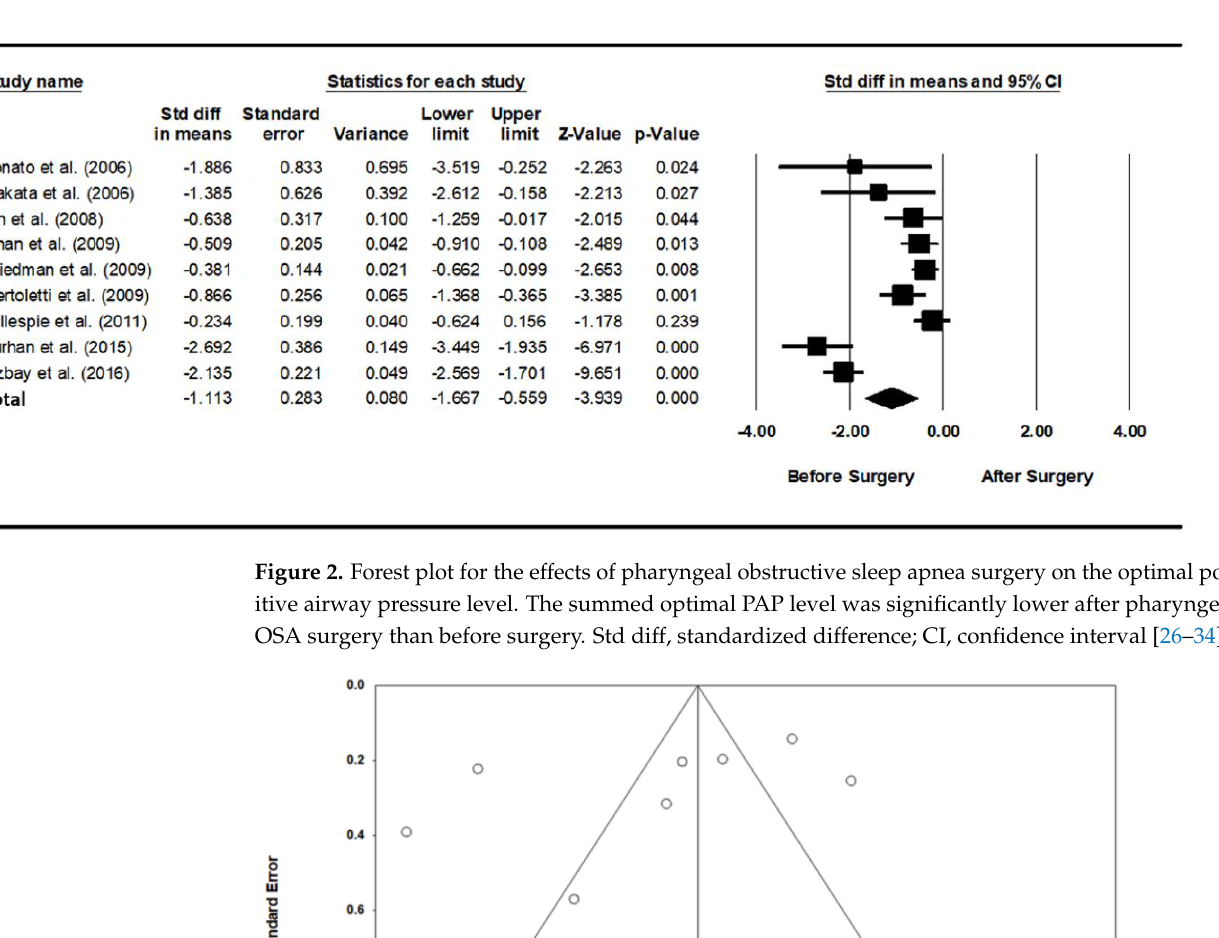
Figure 4. Forest plot for the effects of pharyngeal obstructive sleep apnea surgery on positive airway pressure usage time. The summed usage time of PAP increased significantly after pharyngeal OSA surgery compared to before surgery. Std diff, standardized difference; CI, confidence interval [28,30 – 33].